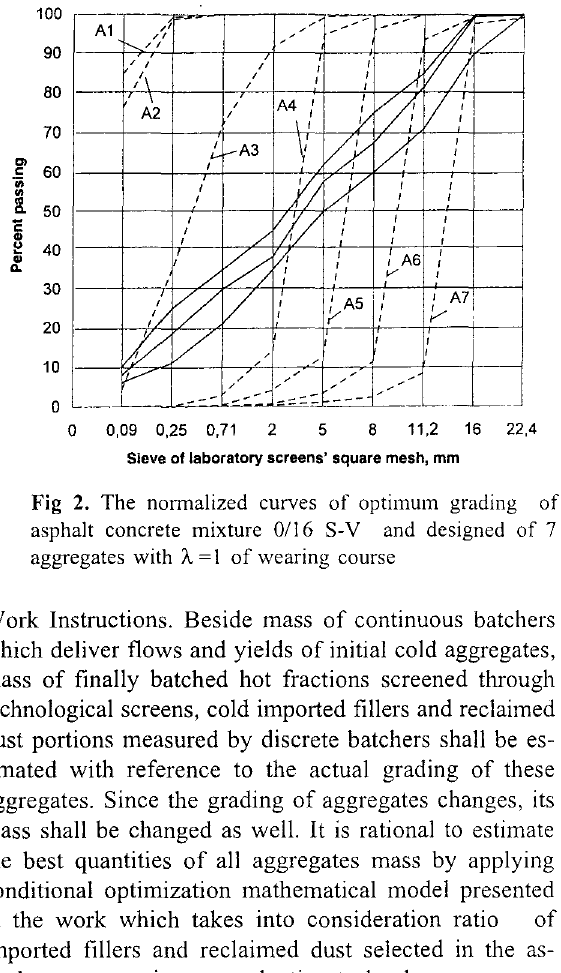
Table 5. The optimum grading of the designed asphalt con crete mixture Size of Lower and Interval Cumulative residue on mesh